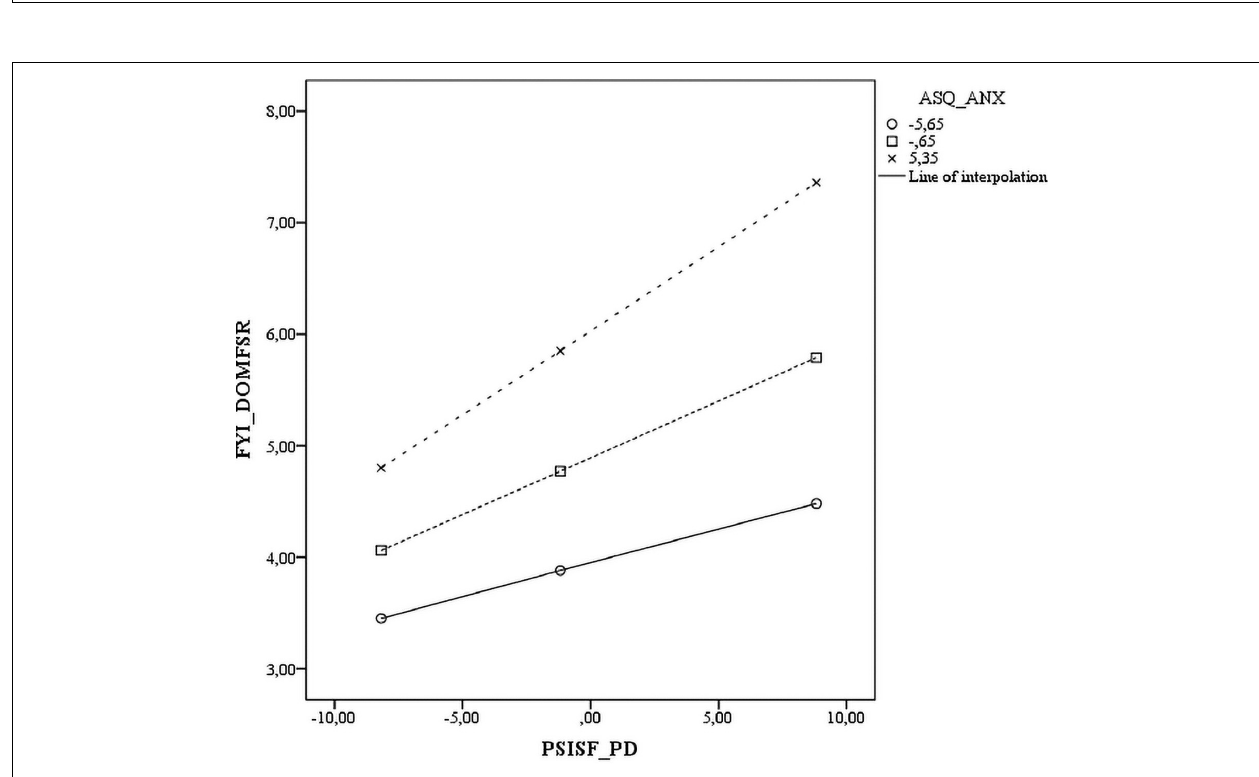
FIGURE 1 | Scatter plot of the interaction between anxious attachment style and parental distress on the socio communicative domain.